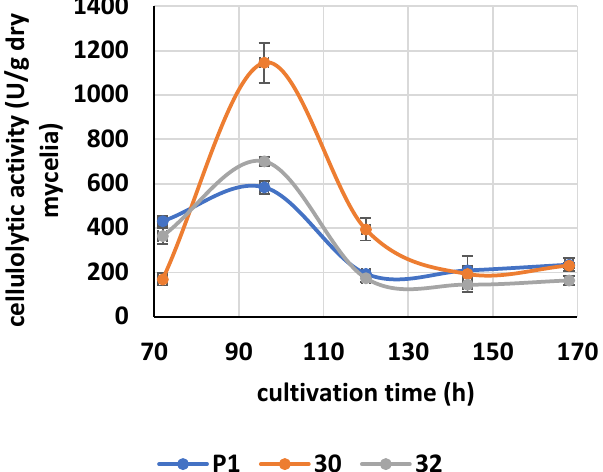
Figure 7. Activities of cellulases in cultivation medium from RER2 -transformed T. atroviride. Con- centration of reducing sugars released from carboxymethylcellulose by cellulases secreted into cultivation medium by the transformants (30 — RER30/11; 32 — RER32/11) and the parental strain P1 were measured. Data are presented as mean ± standard deviation from six independent experiments. Differences are statistically significant ( p < 0.05; t test).